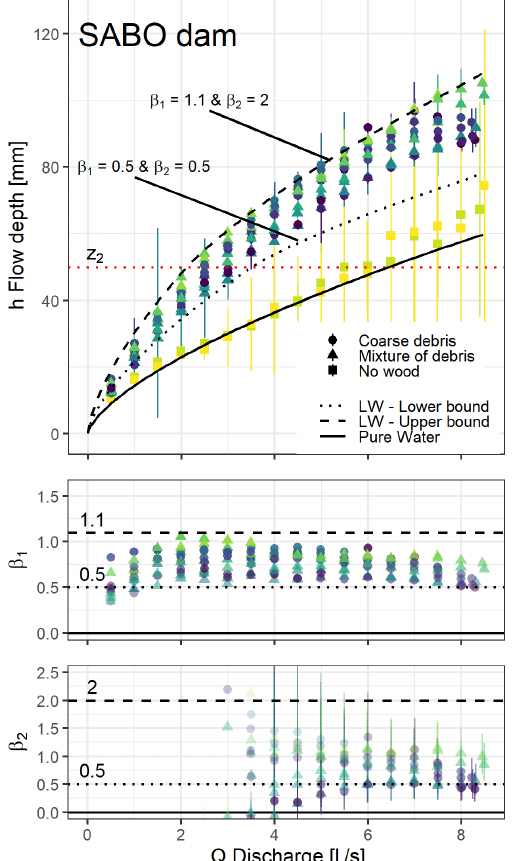
Figure 9. Flow depth versus discharge for sabo dam and back- calculated β 1 and β 2 values; each colour shade corresponds to a different